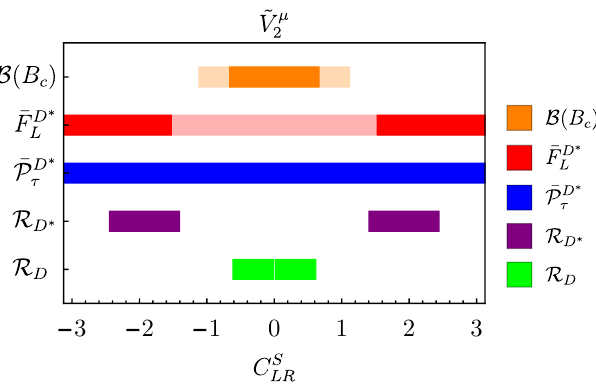
Figure 8 . Fit-independent plot of Scenario 8 . Dark colours correspond to the regions satisfying the experimental constraints at 1 (cid:27) and a 10% upper limit on B ( B c ! (cid:28) (cid:22) (cid:23) ), for a given value of C S Lighter orange and red shaded areas correspond to the more relaxed 30% bound on the leptonic B c decay and the 2 (cid:27) region for (cid:22) F D (cid:3) , L